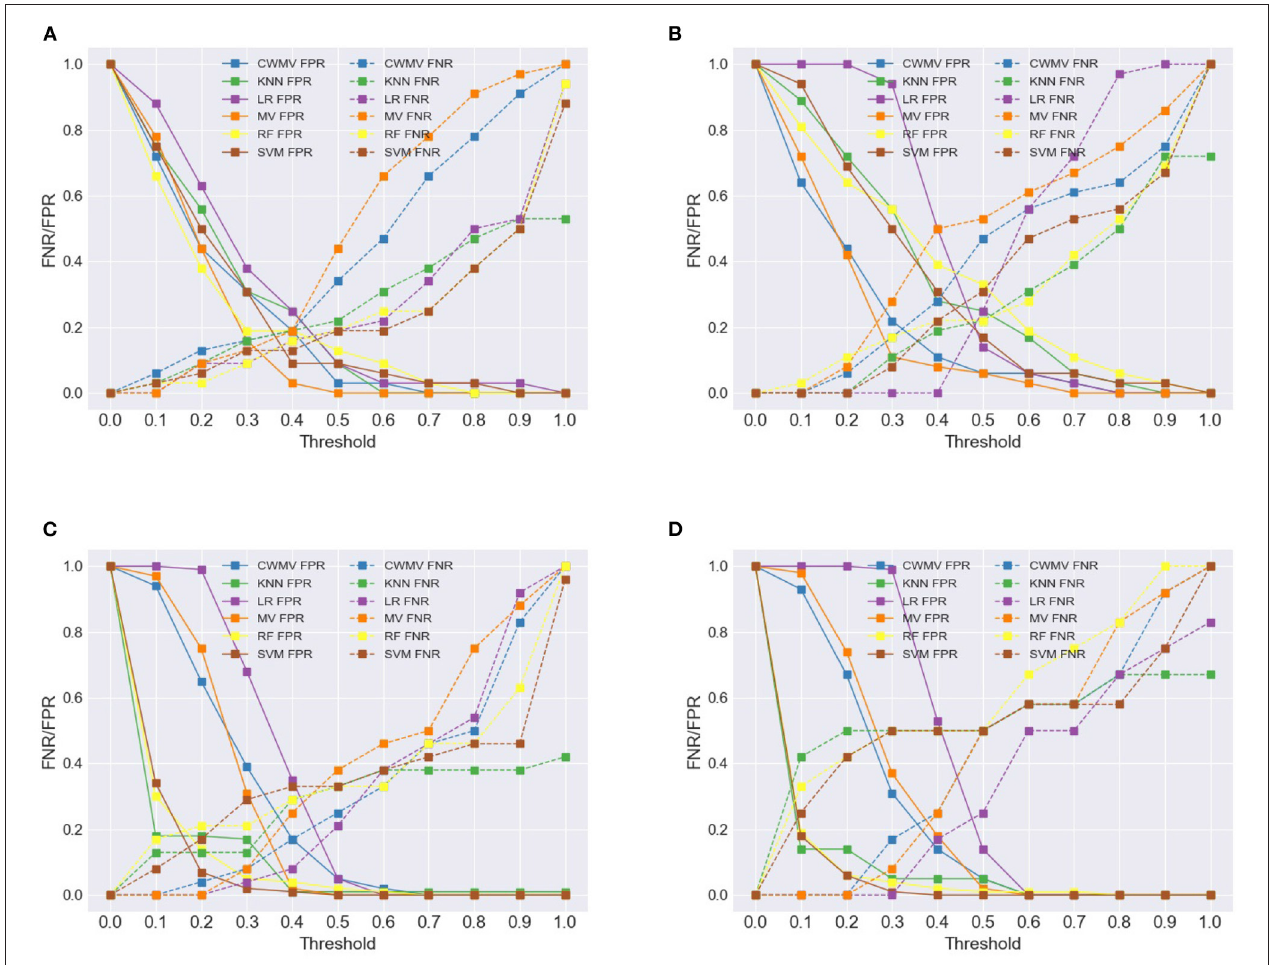
FIGURE 5 | Change in FNR/FPR of different aggregation methods under varying thresholds. (A) Experiment Set A, (B) Experiment Set B, (C) Experiment Set C, (D) Experiment Set